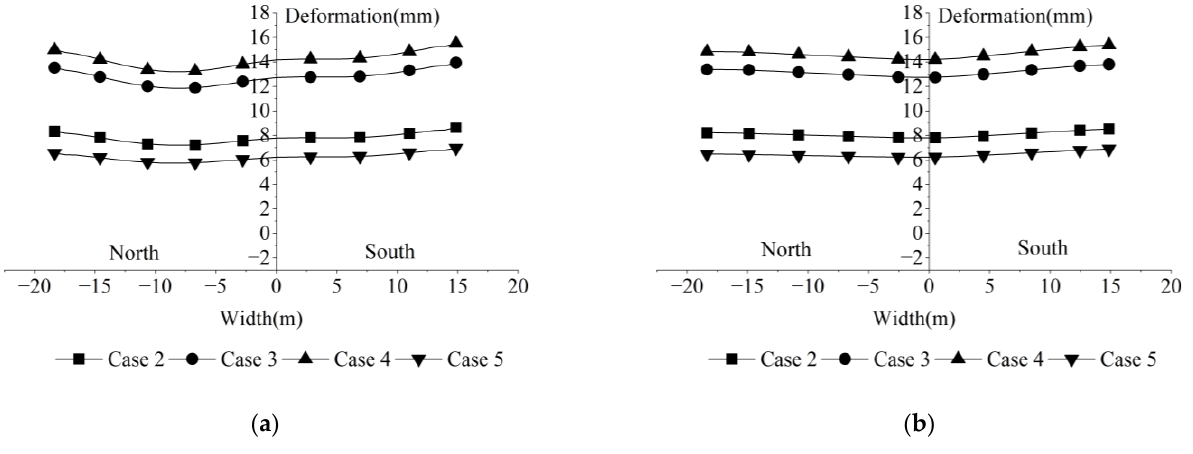
Figure 13. Vertical deformation of structural slab subjected to symmetric construction: ( a ) bottom slab and ( b ) top slab (unit: mm).